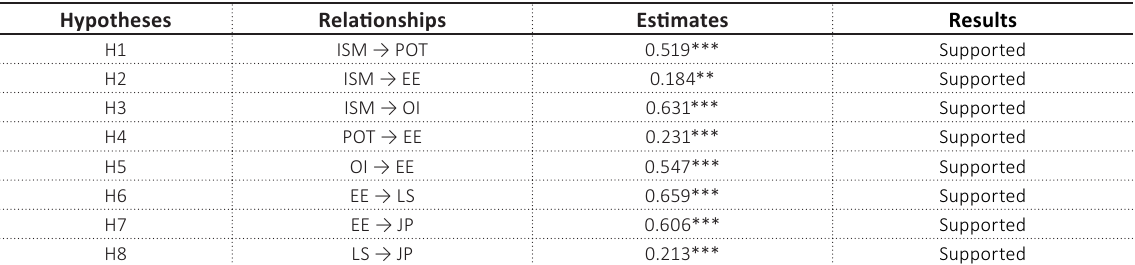
Source: Authors’ elaboration.